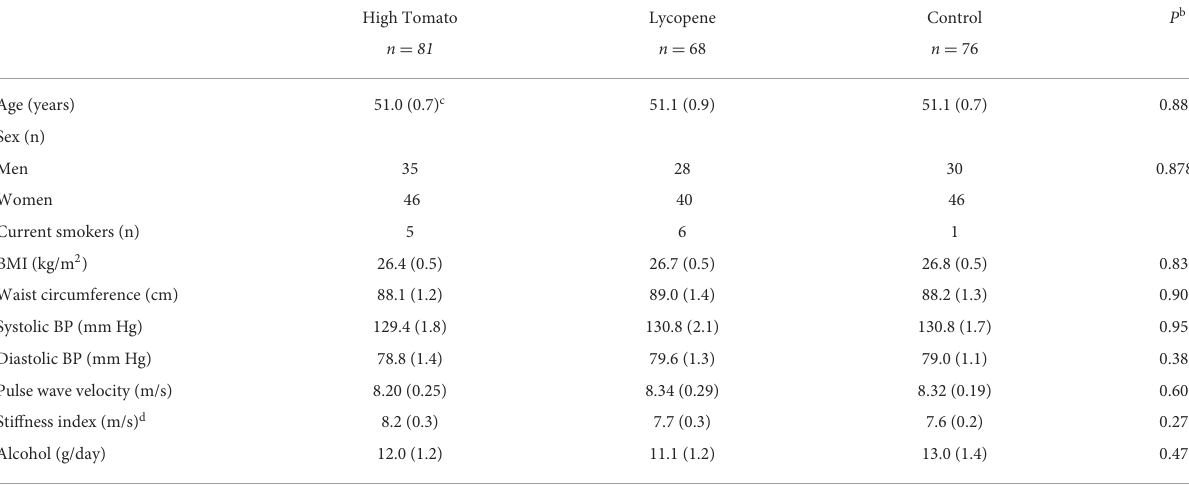
TABLE 2 Participant characteristics at baseline, by the intervention group a